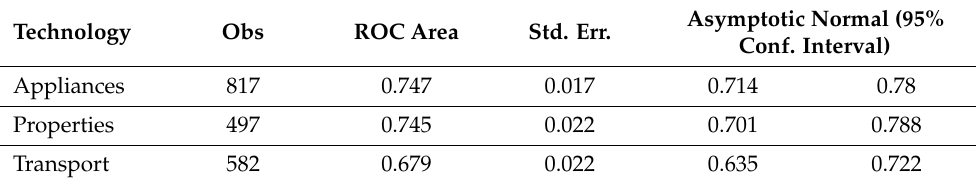
Table 7. Comparison of the ROC areas—technology subsample models